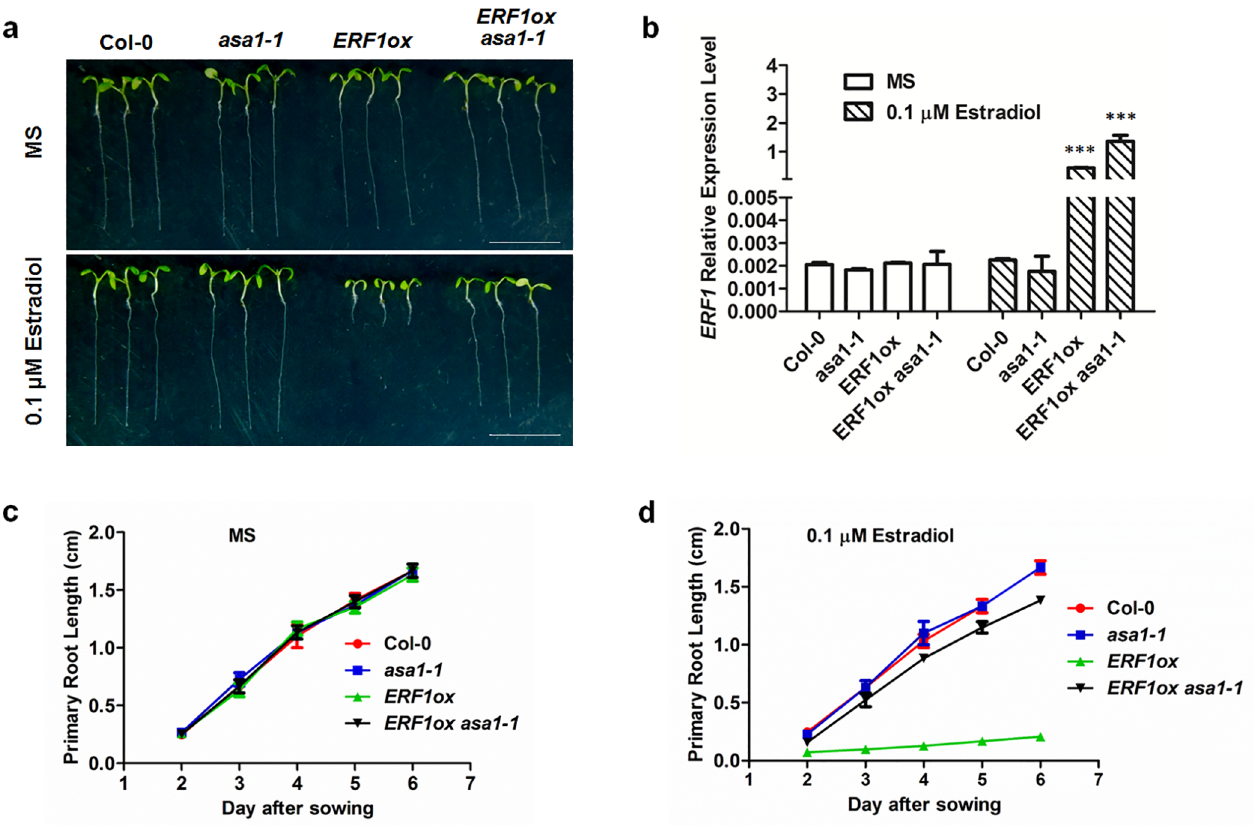
Fig 8. ASA1 acts downstream of ERF1. (a) The primary root phenotypes of Col-0, asa1-1 , ERF1ox and ERF1ox asa1-1 seedlings grown on MS medium with either 0 or 0.1 μ M estradiol for 5 d. ERF1ox is the transgenic plants expressing ERF1 protein under control of the estradiol-inducible promoter in Col-0 background. Scale bar, 1 cm. (b) qRT – PCR analysis of transcriptions of ERF1 . The roots of 5-day-old Col-0, asa1-1 , ERF1ox and ERF1ox asa1-1 seedlings grown on MS medium with either 0 or 0.1 μ M estradiol were used. Values are mean ± SD of three replicas ( *** P < 0.001. Asterisks indicate Student ’ s t-test significant differences). (c-d) . Primary root length of Col-0, asa1-1 , ERF1ox and ERF1ox asa1-1 seedlings grown on MS medium with either 0 or 0.1 μ M estradiol were measured. Data shown are average and SD (Values are mean ± SD, n = 20).